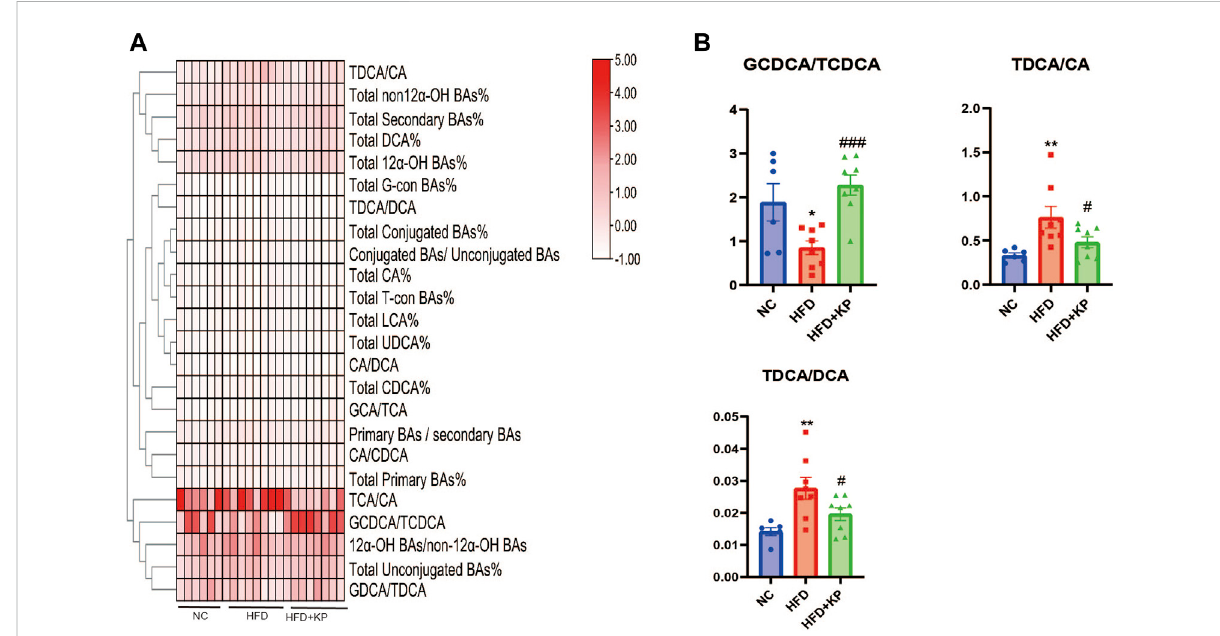
FIGURE 2 Comparison of serum BA ratios and percentage among three groups. (A) Heatmap of serum BA ratios and percentage among three groups. (B) Differential serum BA ratios signi fi cantly differed among three groups. All values were expressed as mean ± SEM. * p < 0.05 and ** p < 0.01, when NASH models (the HFD group) were compared to control groups (NC group); # p < 0.05, ## p < 0.01, and ### p < 0.001, when NASH models (the HFD group) were compared to NASH models treated with kaempferol (the HFD + KP